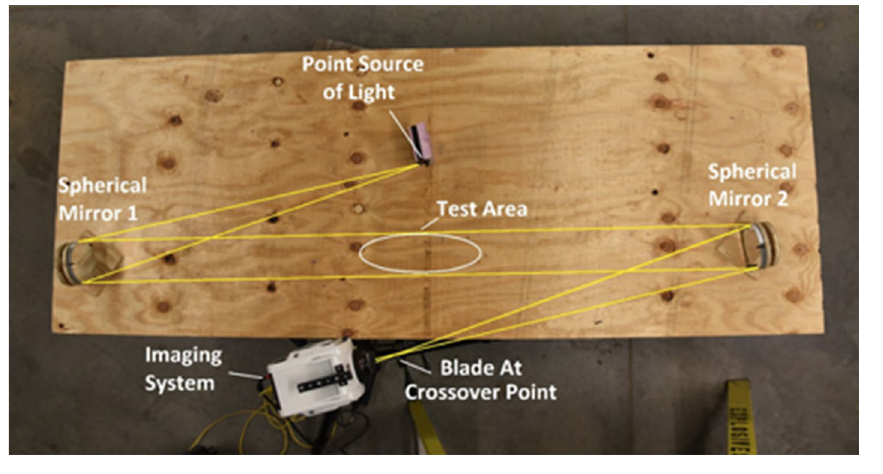
Figure 6. Schlieren test